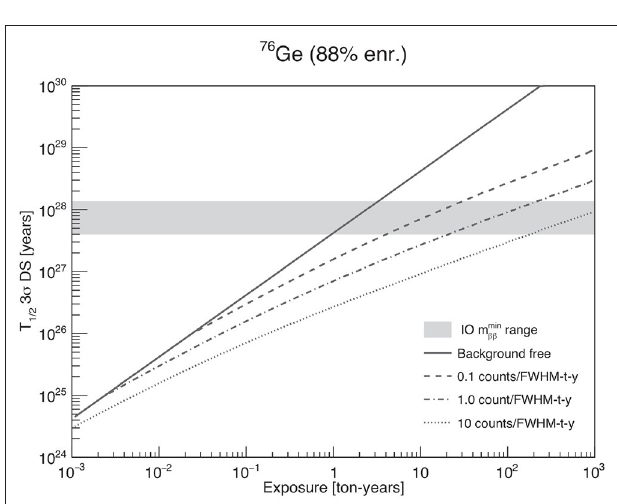
FIGURE 9 | The 3 σ discovery potential for a 76 Ge experiment for several potential background levels. Figure courtesy of Jason Detwiler.